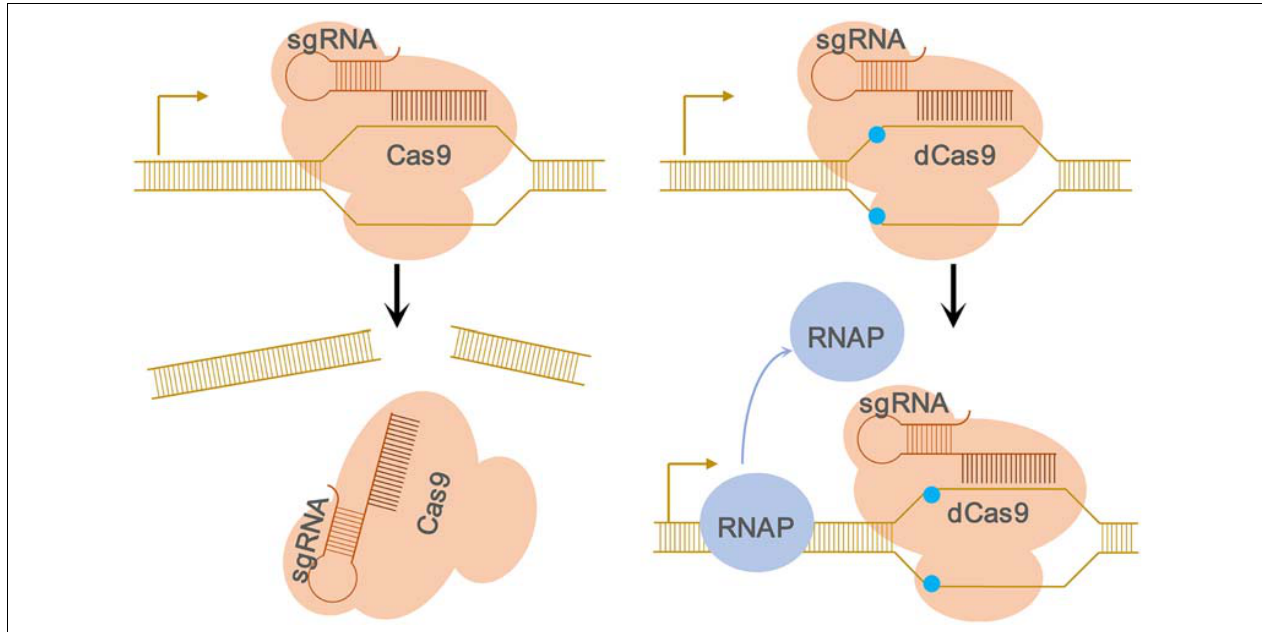
FIGURE 1 | Schematic of the CRISPRi approach. Left , Cartoon representation of the CRISPR-mediated regulation of gene expression. The wild-type Cas9 protein binds to the sgRNA and forms a protein–RNA complex. Once Cas9–sgRNA complex binds to specific DNA target adjacent to PAM, it leads to the cleavage of the target DNA due to the nuclease activity of the Cas9 protein. Right , Cartoon depicting the CRISPRi-mediated interference of gene expression caused by nuclease-deficient dCas9. The nuclease-deficient dCas9 contains two substitutions in the nuclease domains (D10A and H840A, blue dots), and thus lose the endonuclease activity. If the target DNA sequence locates inside an open reading frame, the dCas9–sgRNA–DNA complex will block the movement of RNAP and subsequent transcription elongation, resulting in transcription inhibition of the target